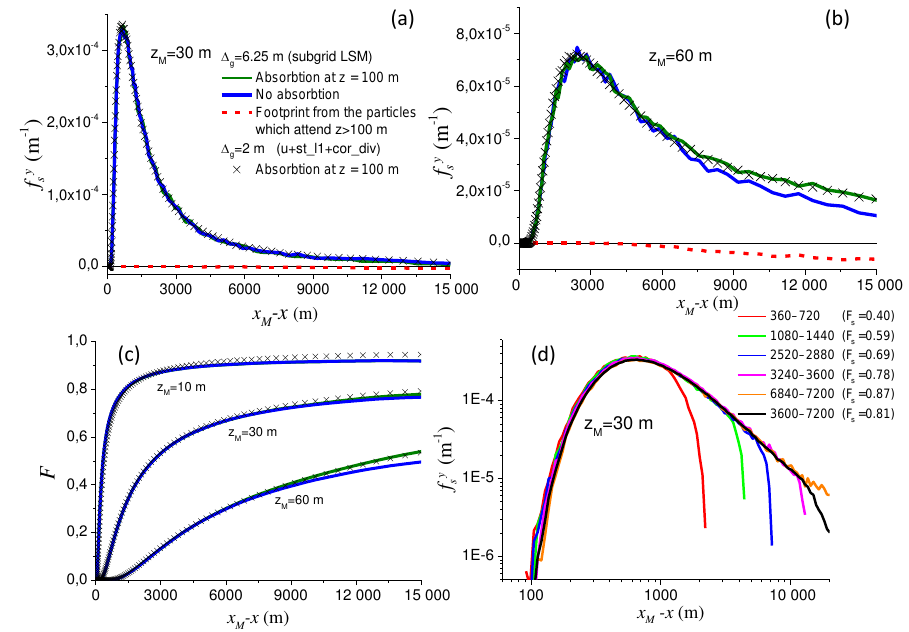
Figure A1. The footprint functions f y s (a, b) and the cumulative footprints F (c) obtained without the prescribed absorbtion (blue lines) in comparison with the results of simulation where the absorbtion is imposed at level z = 100m (green lines). Red dashed lines are the footprints from the particles that attained level z = 100m. (d) Footprints obtained with the different intervals of averaging (cid:2) t 1 ,t 2 (cid:3) (shown in seconds in the legend), the normalized vertical concentration fluxes (cid:104) F s (z M )/F s ( 0 ) (cid:105) [ t , are shown in 1 ,t 2 ]